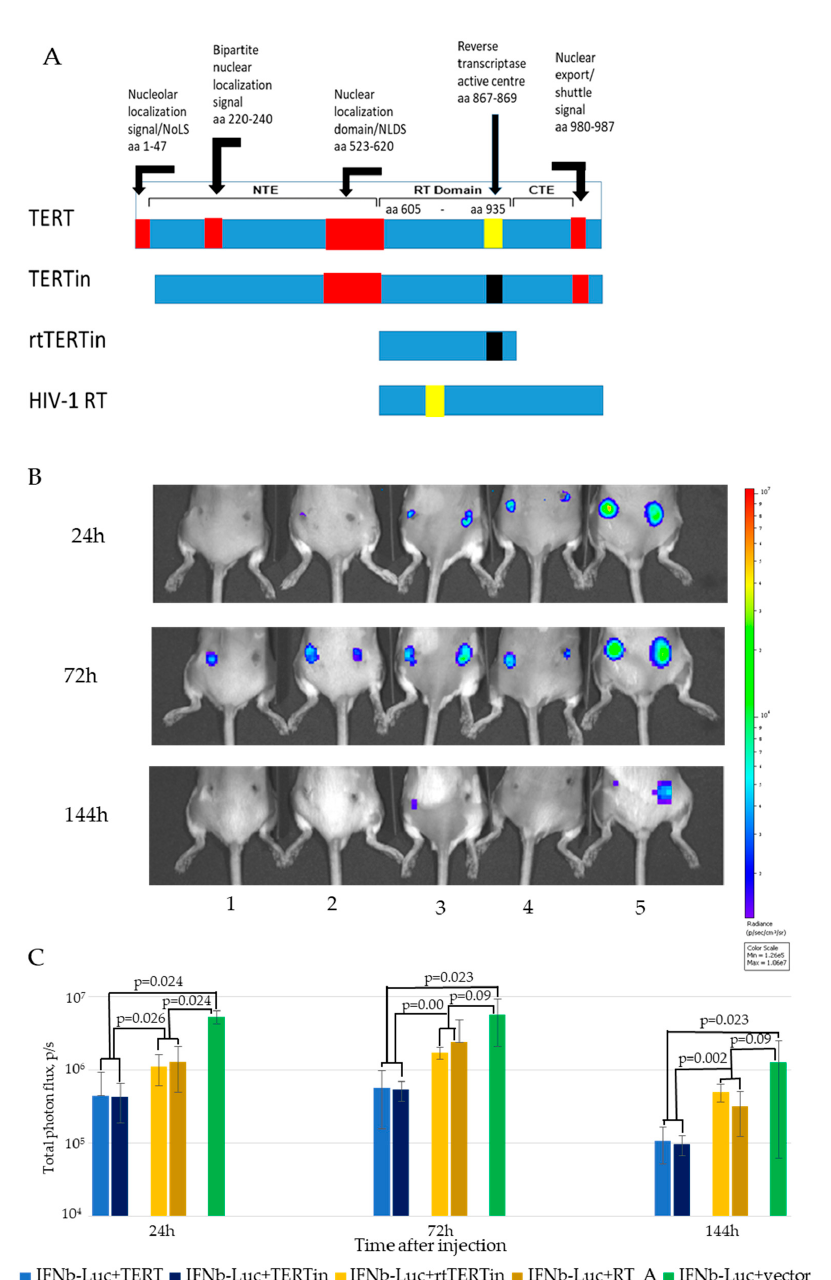
Figure 9. Enzymatically active TERT affects in vivo expression of luciferase reporter from a promoter of type I IFN gene. Reporter plasmid IFN-Beta_pGL3 directing synthesis of luciferase under the control of IFN- β promoter was co-injected into mice together with plasmids encoding Individual mice receiving injections of IFN-Beta_pGL3 (IFNbLuc) mixed with plasmids encoding active TERT (pVaxTERT), or inactivated TERT with deleted nucleolar localization signal and active center VDD (TERTin; pVaxTERTin), or its inactivated reverse transcriptase domain (rtTERTin; pVaxrtTERTin), or control protein, enzymatically active consensus reverse transcriptase of HIV-1 (RT_A; pVaxRThiv(a)) [38]. Schematic representation of the proteins, positions of signals and domains refers to human TERT (uniprot/O14746; positions of localization signals (red boxes), active center (yellow boxes) and mutated active center (black boxes) are indicated based on the publications [37,56–59] ( A ); sites of co-injections of IFN-Beta_pGL3 with pVaxTERT (1), or pVaxrtTERT (2), or pVaxTERTin (3), or pVaxRThiv(a) (4), or pVax1 (5) assessed 24, 72 and 144 h post injection ( B ); Level of photon flux from mice receiving the above injections ( n = 3–4 per plasmid mix) ( C ). Color scale to the right from the images in panel B reflects signal intensity (photons/sec). Panel C, average level of photon flux ± STDV, pairwise comparison by Mann-Whitney U